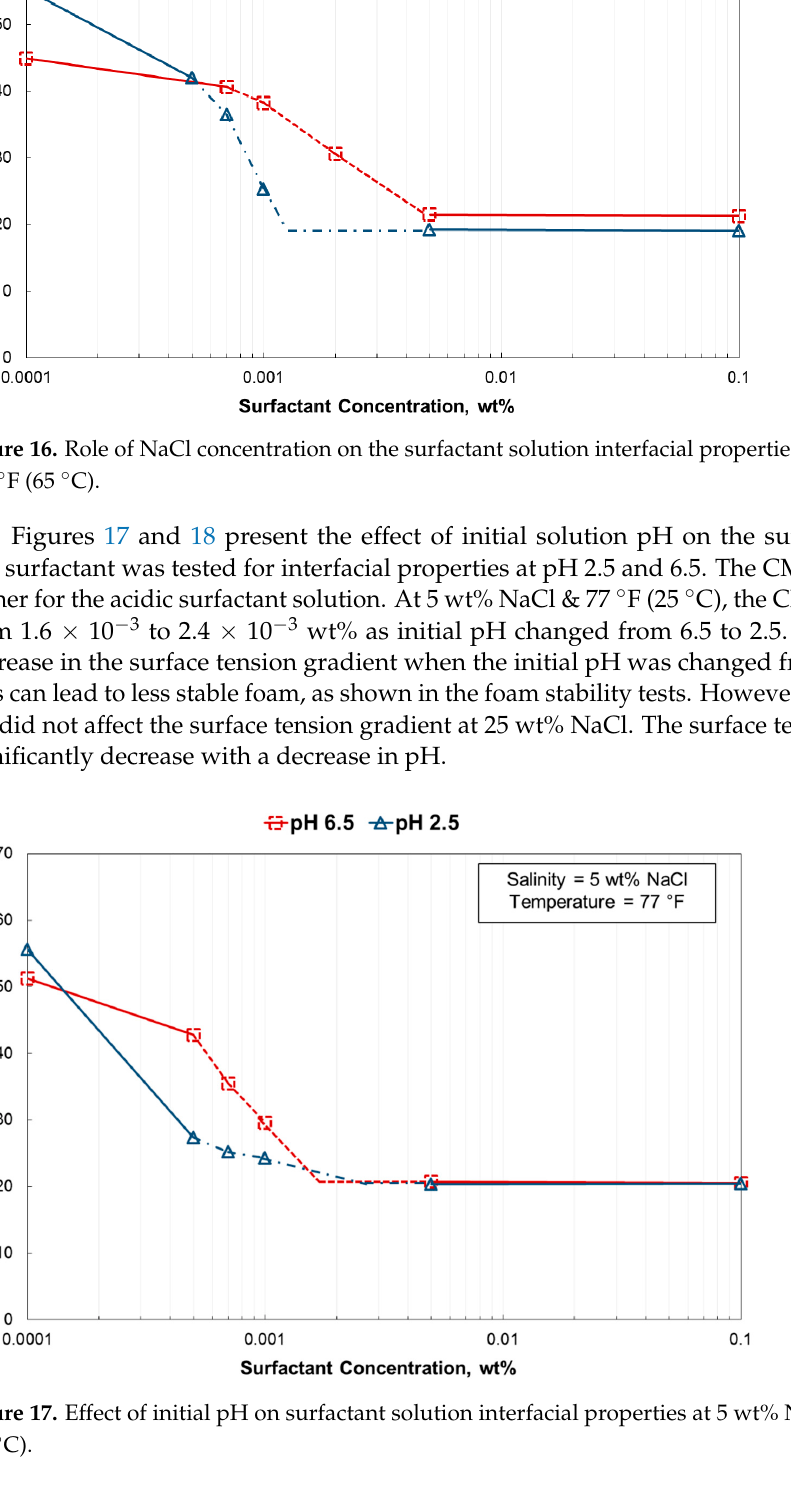
Figure 15. Role of NaCl concentration on the surface tension, CMC, and surface tension gradients at pH 6.5 and 77 °F (25 °C).